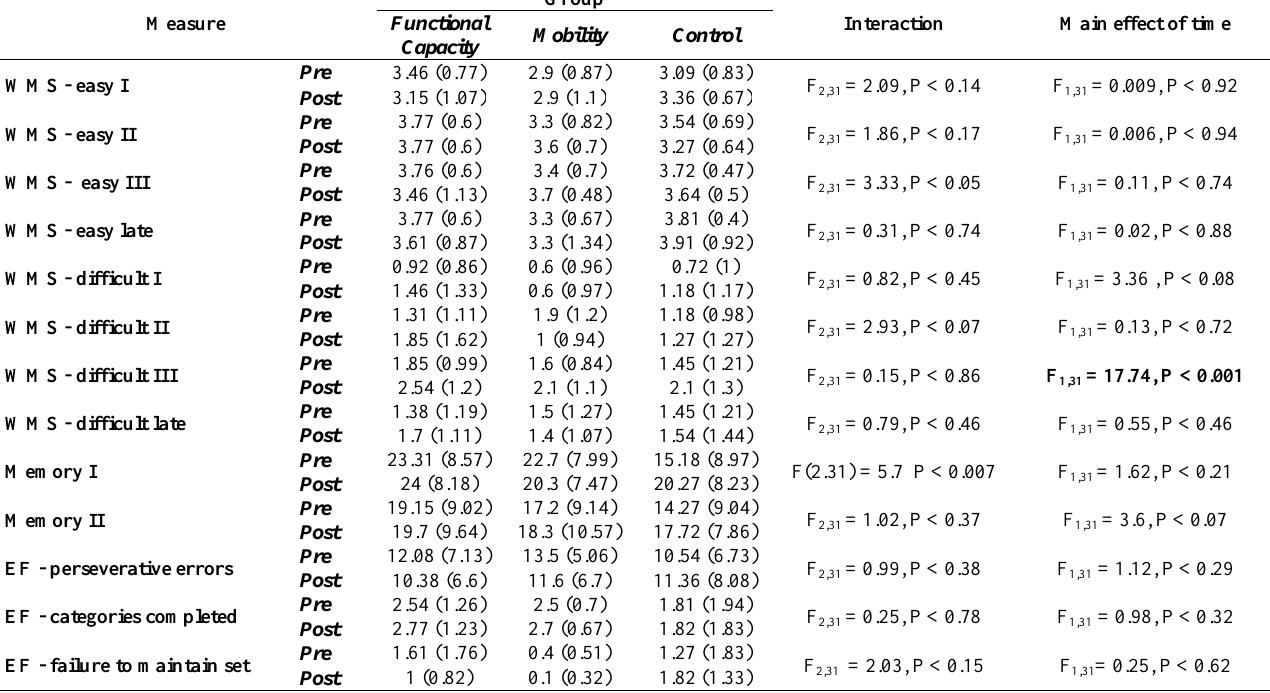
Table 3. Means (standard deviation) of memory and executive functions (EF) dependent variables for each group at before (pre) and after (post) intervention and statistical values. Verbal Paired Associates (WMS - easy I, II, III and late and difficult I, II, III and late) analyzed immediate memory, learning, episodic declarative memory and the ability to recall. Logical memory I and II analyzed immediate memory, episodic declarative memory and the ability to recall. Perseverative errors, categories completed and failure to maintain set analyzed abstraction, mental flexibility and attention